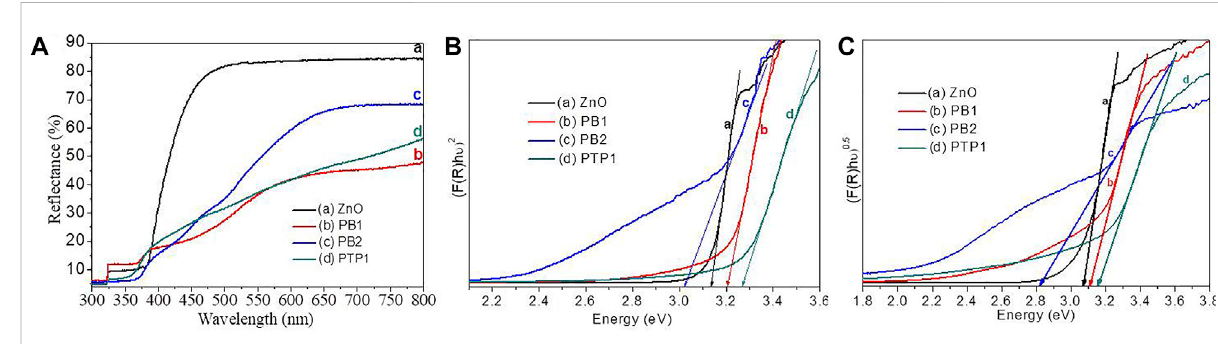
FIGURE 4 Optical properties analysis: (A) DRS plots. (B) and (C) the direct and indirect Kubelka – Munk plots of ZnO NPs and PB1, PB2, and PTP1 NCs calcined at 500 ° C.